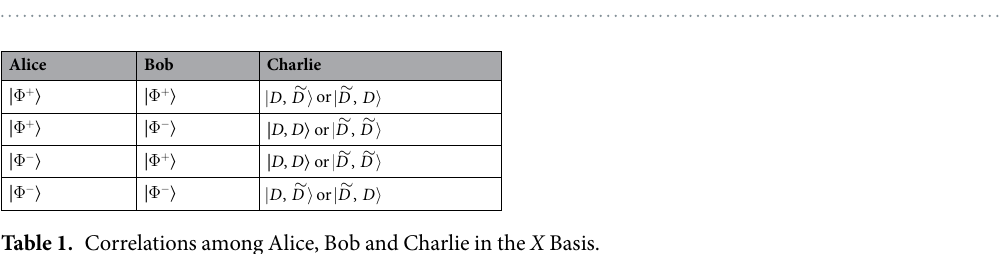
Table 1. Correlations among Alice, Bob and Charlie in the X